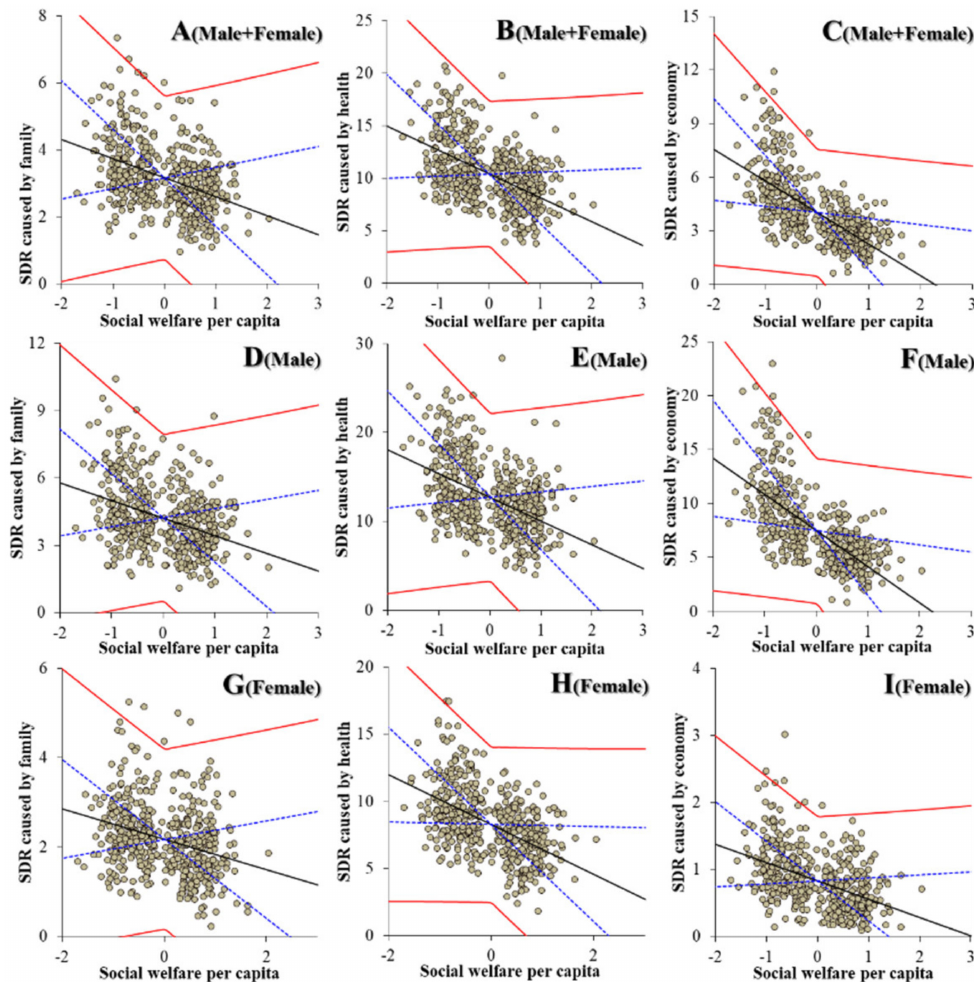
Figure 6. Relationship between financial expenditure per capita of social welfare of prefectures and municipalities, and suicide mortalities of males + females ( A – C ), males ( D – F ) and females ( G – I ) caused by motives associated with family ( A , D , G ), health ( B , E , H ) and economy ( C , F , I ), and suicide mortality of both genders (males + females) caused by family ( A , D , G ), health ( B , E , H ) and economy ( C , F , I ) from 2009 to 2018 by fixed- or random-effect analysis of hierarchal linear regression with robust standard error. Ordinates and abscissas indicate SDR of suicide mortalities (per 100,000 population) and centralised (by average) social welfare expenditure per capita of prefectures plus municipalities (JPY 10,000), respectively. Black, blue and red lines are the slope of fixed effects, standard deviation of fixed effects and fixed effects with random effects,